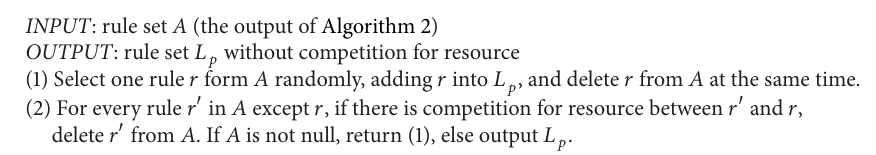
Algorithm 3: Rule selection algorithm with “competition for resource”.